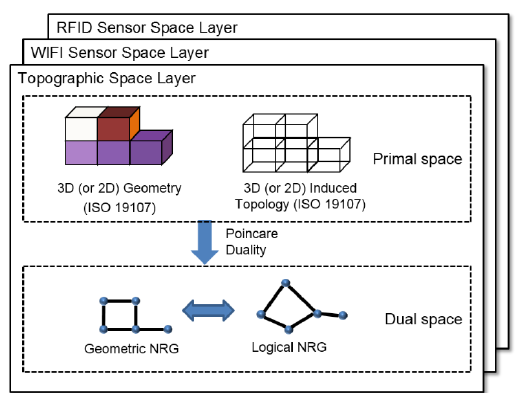
Figure 5. MLSM concept